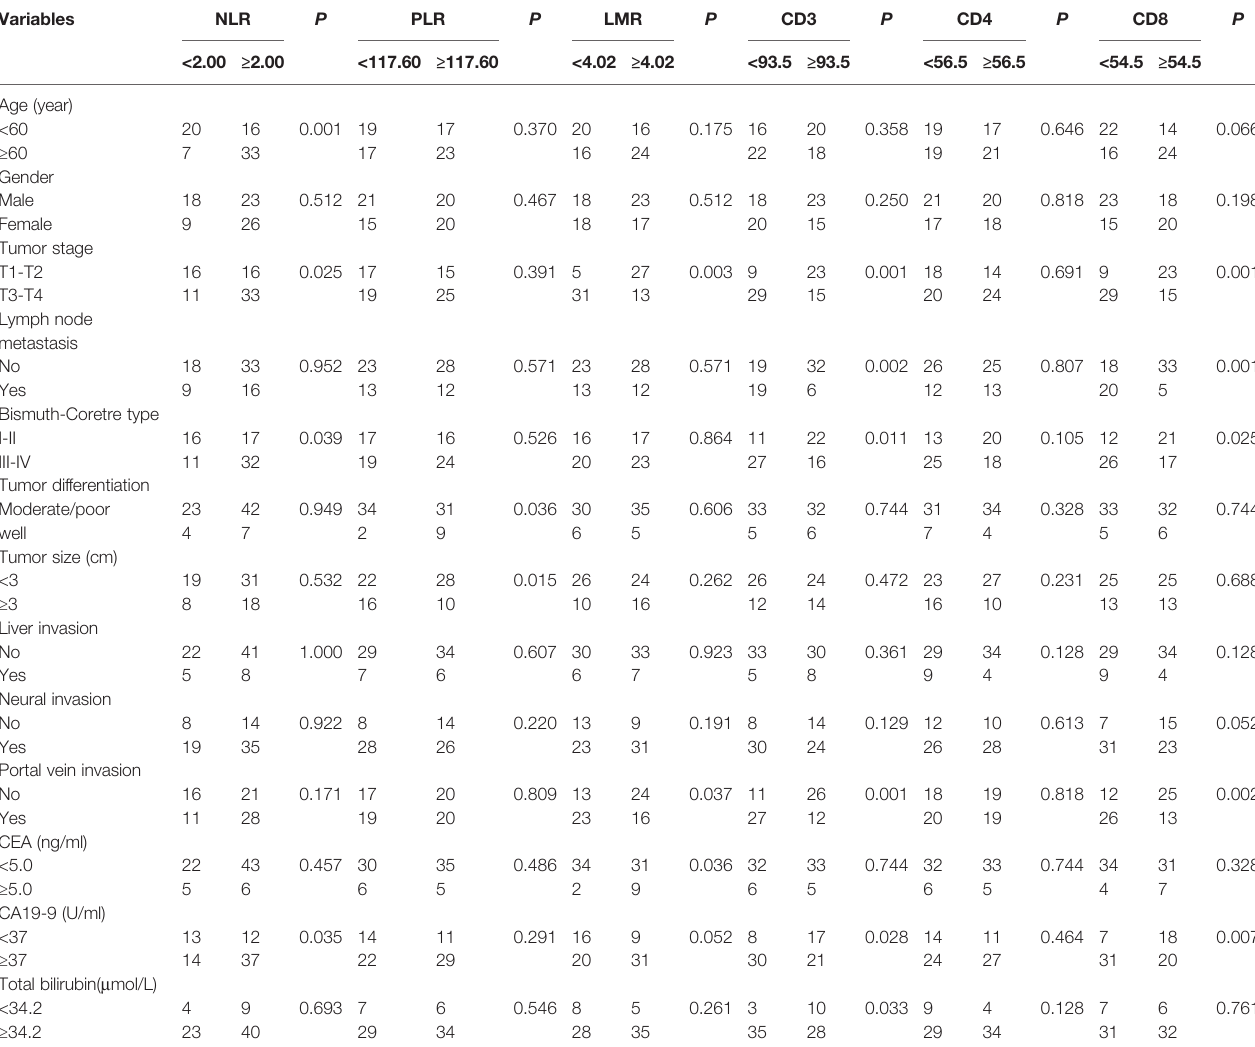
TABLE 2 | Characteristics of the patients grouped immune cells and peripheral blood.